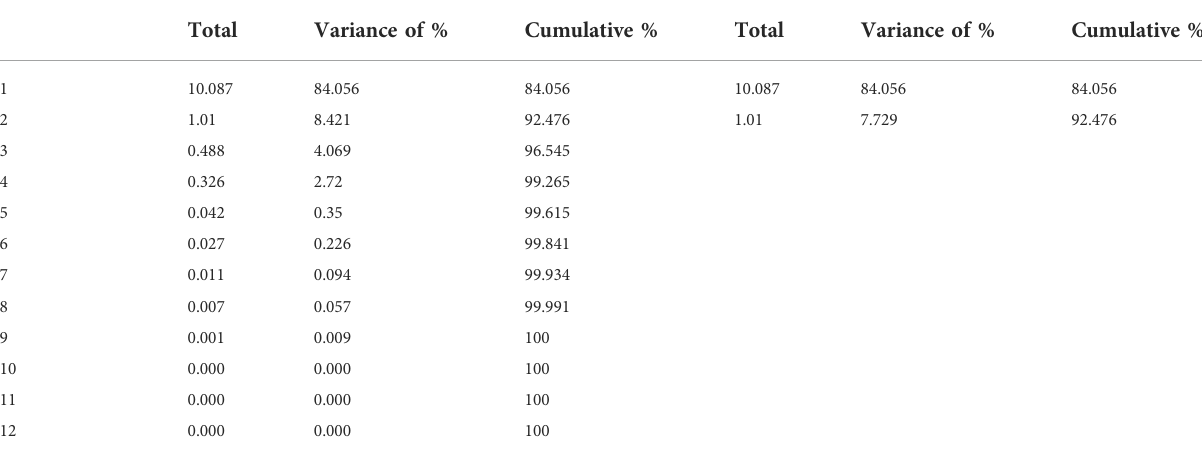
TABLE 4 Total variance